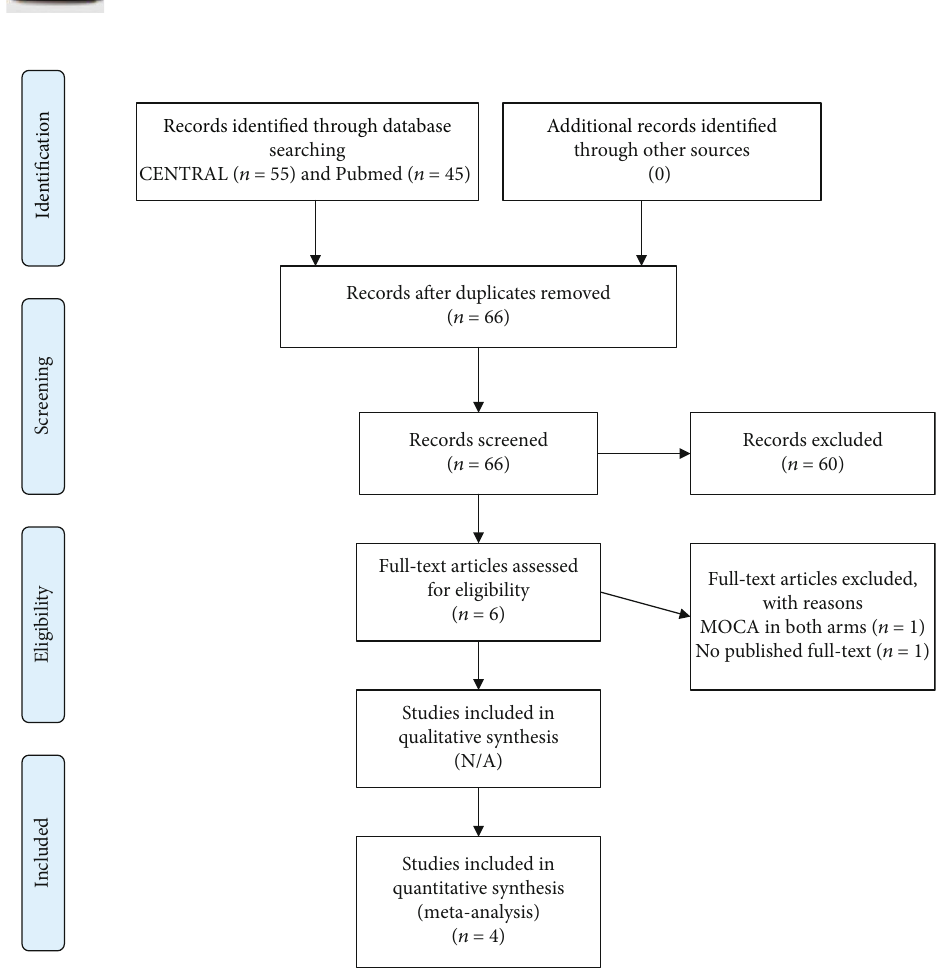
Figure 1: PRISMA fl ow